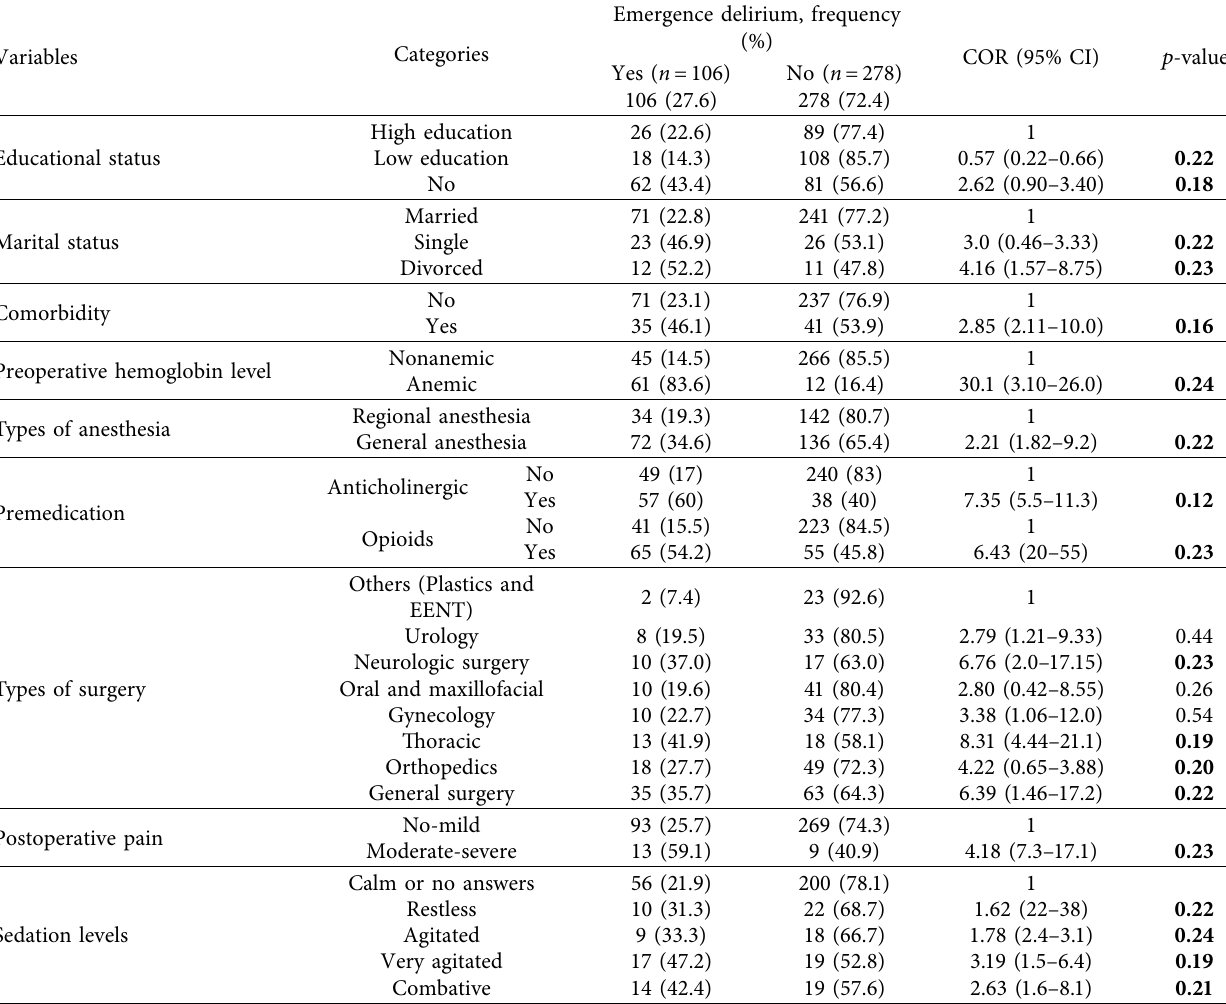
Table 3: Bivariable logistic regression of factors associated with the emergence delirium in older patients who underwent elective surgery in the teaching hospitals of Ethiopia, Ethiopia ( n � 384).